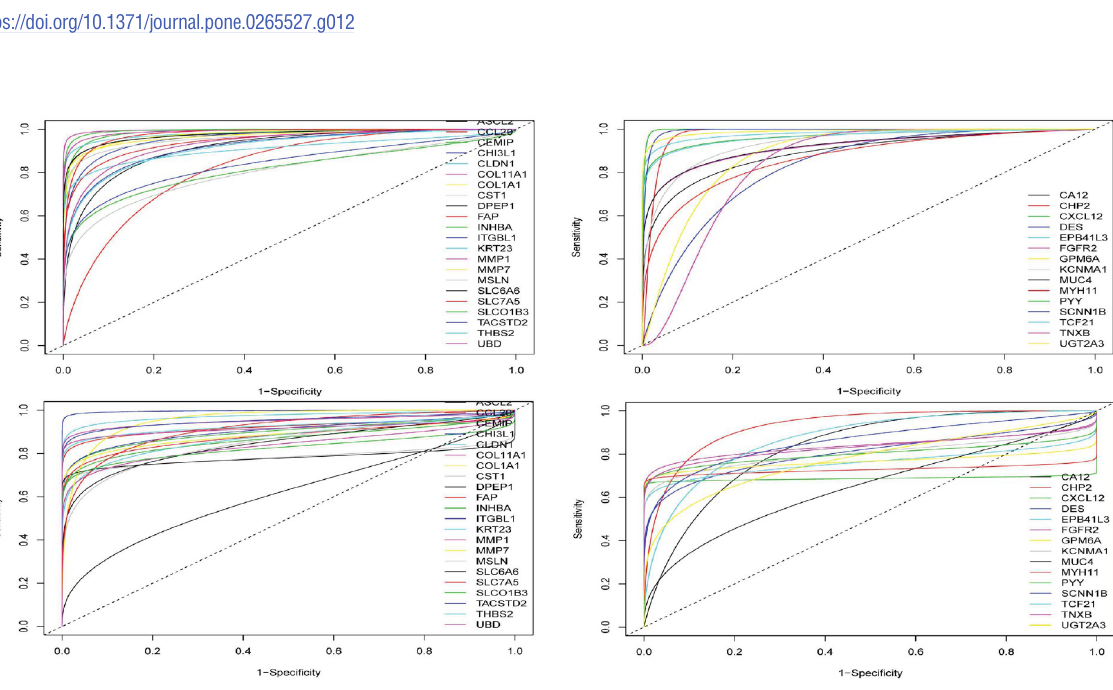
Fig 13. ROC curves for known validated Differentially Expressed Genes-Differentially Methylated Genes (vDEGs-DMGs). The top curves) Expression profiles. The bottom curves) methylation profiles. The left curves) Over-expressed/hypo-methylated vDEGs-DMGs. The right curves) Under-expressed/hyper-methylated vDEGs-DMGs.